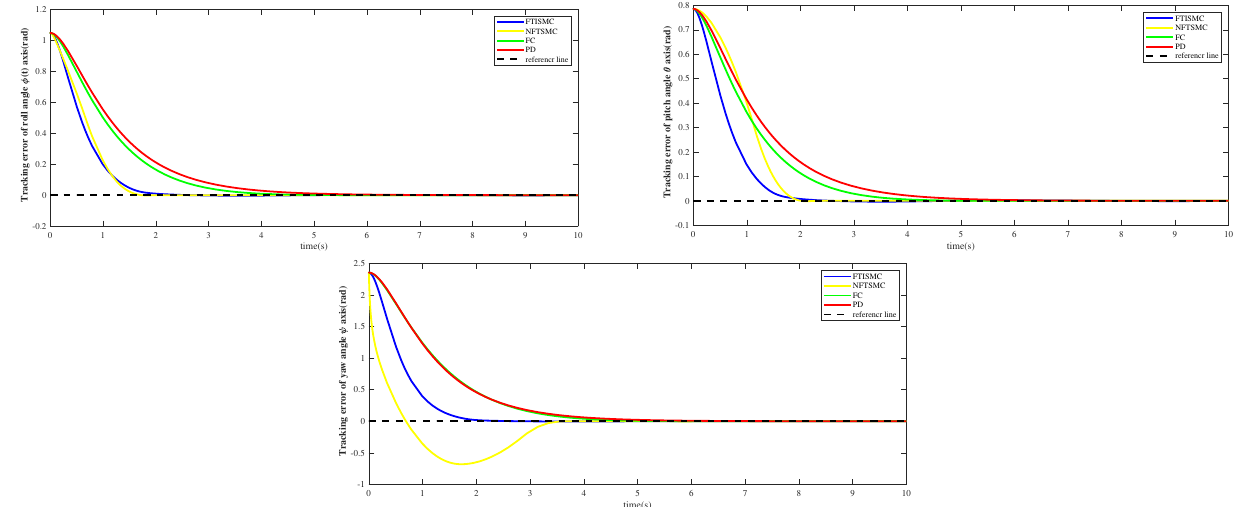
Figure 2. Attitude angle tracking error of different controllers.